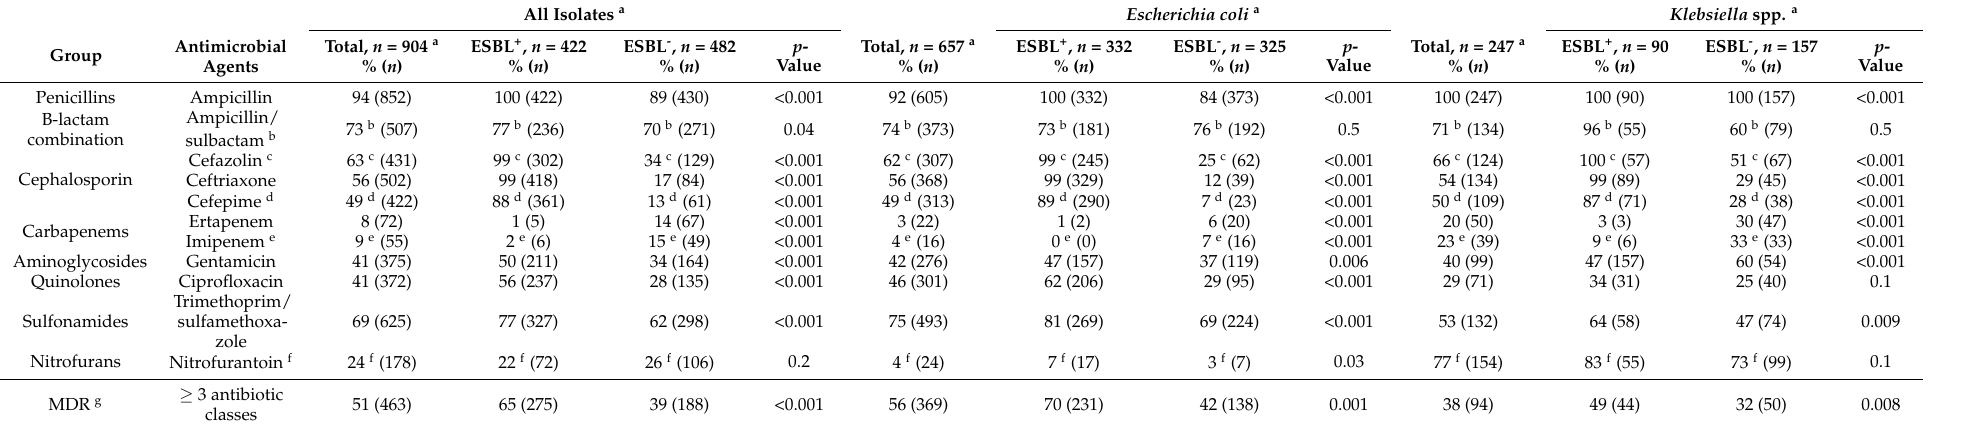
Table 3. Phenotypic antibiotic resistance of Enterobacterales from vaginal swabs of Vietnamese pregnant women 2016–2020 ( n = 904). All Isolates a Escherichia coli a Klebsiella spp.